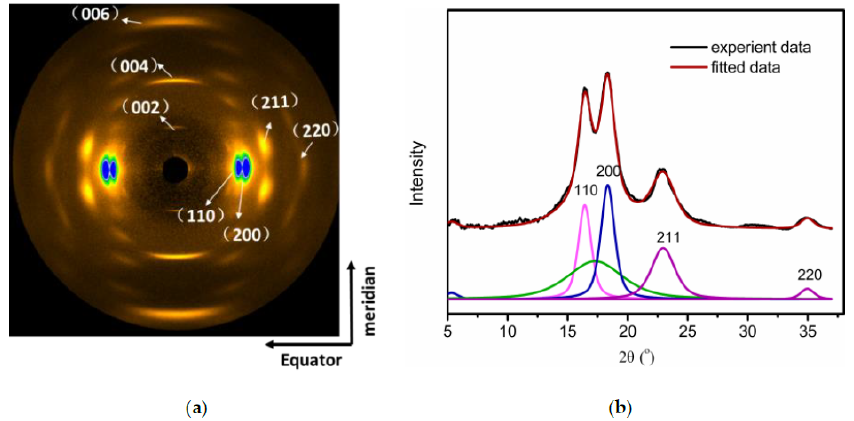
Figure 2. ( a ) Two dimensional wide-angle X-ray scattering (WAXS) patterns and ( b ) one-dimensional WAXS profiles and fitting results for Kevlar49 fibers as received.